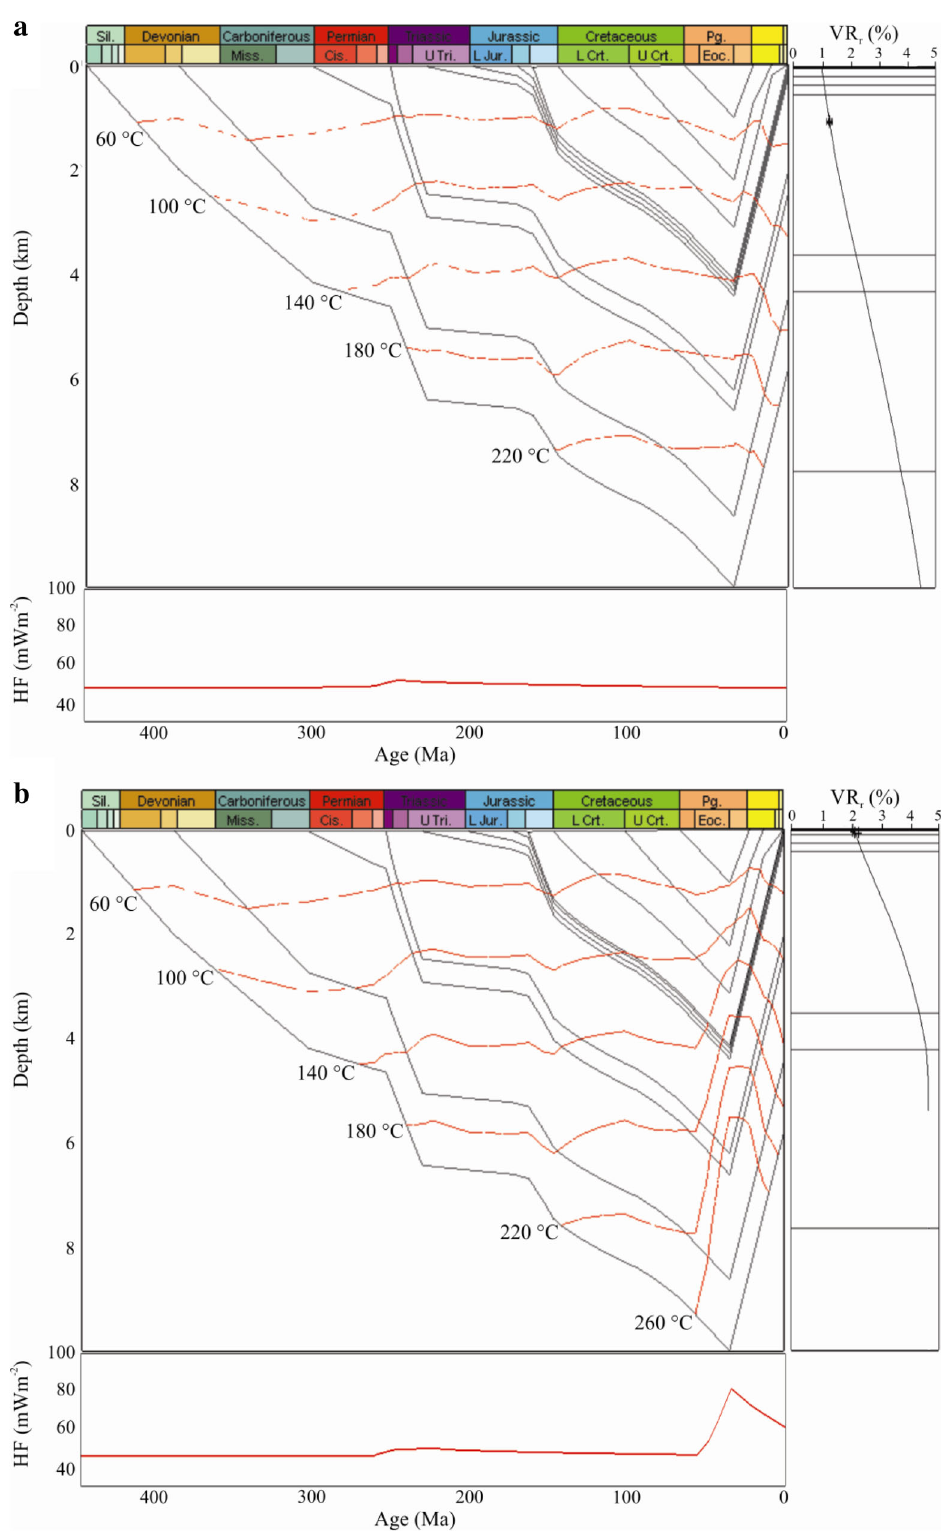
Fig. 11 Burial and thermal history at the locations of Parvadeh ( a ) and Mazino ( b ) including basal heat flow history and model